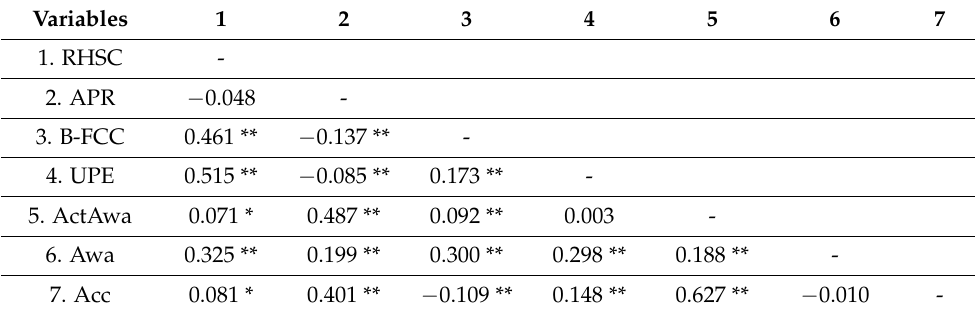
Table 10. Correlations between IES-2 and MES subscales.